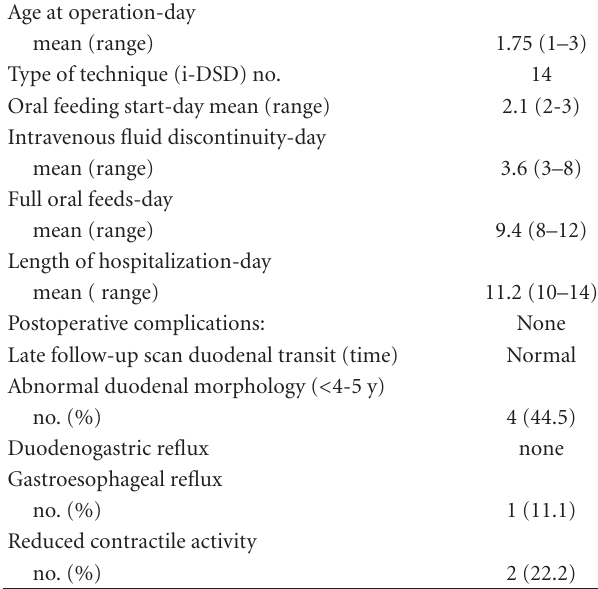
Table 2: Procedures and results in patients operated on for